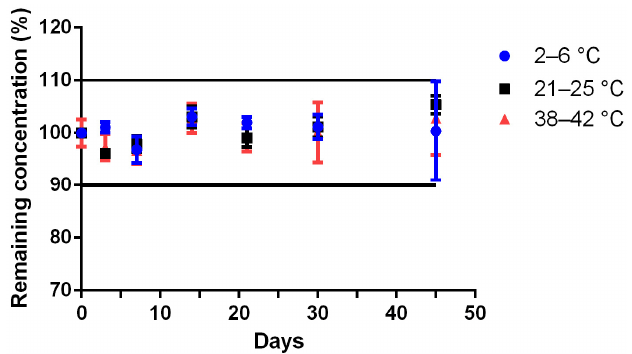
Figure 5. Stability of Methionine 200 mg/mL suspension at 4 ± 2 ◦ C (blue circle), 23 ± 2 ◦ C (black square), 40 ± 2 ◦ C (red triangle) in glass pharmaceutical bottles and over time (remaining methionine concentration, calculated by the ratio of the concentration on the tested day to the concentration at day 0; values are mean ± SD; n = 3).